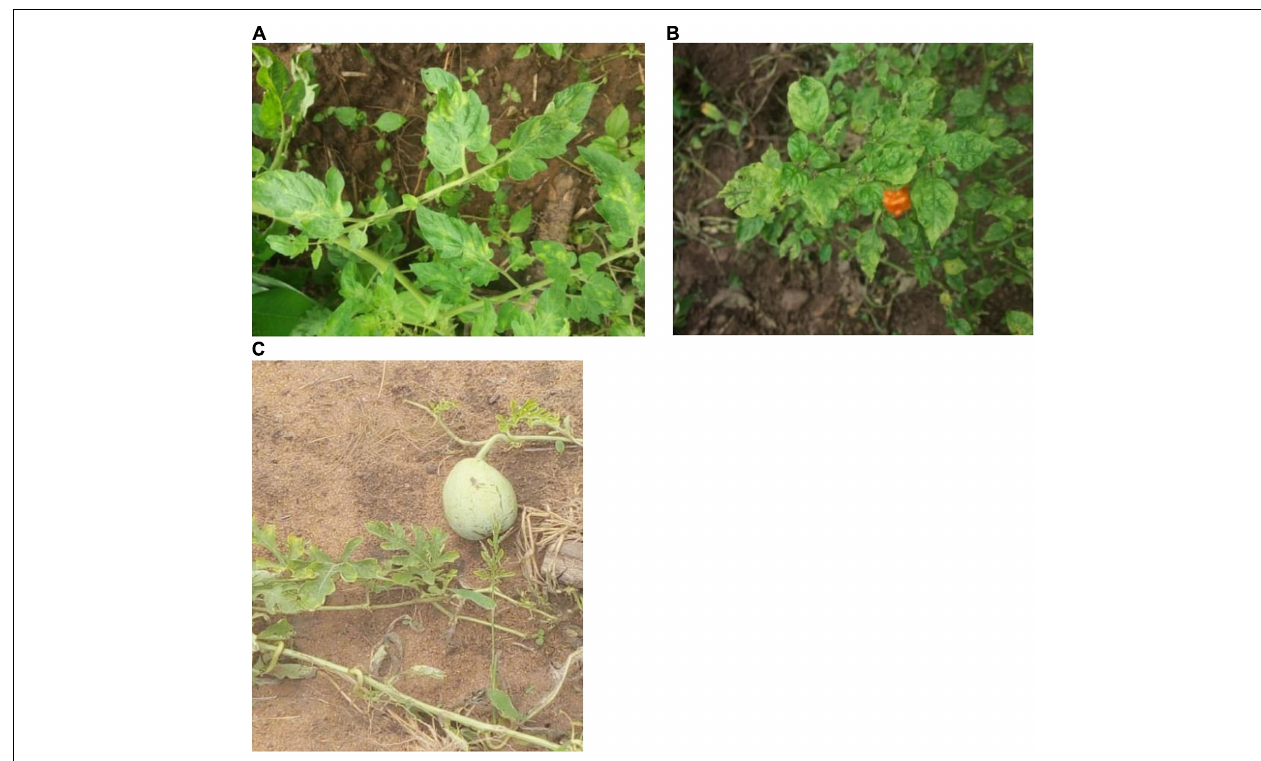
FIGURE 2 | Symptoms on tomato (A) , pepper (B) , and watermelon (C) plants sampled for natural CMV infection in Nigeria.